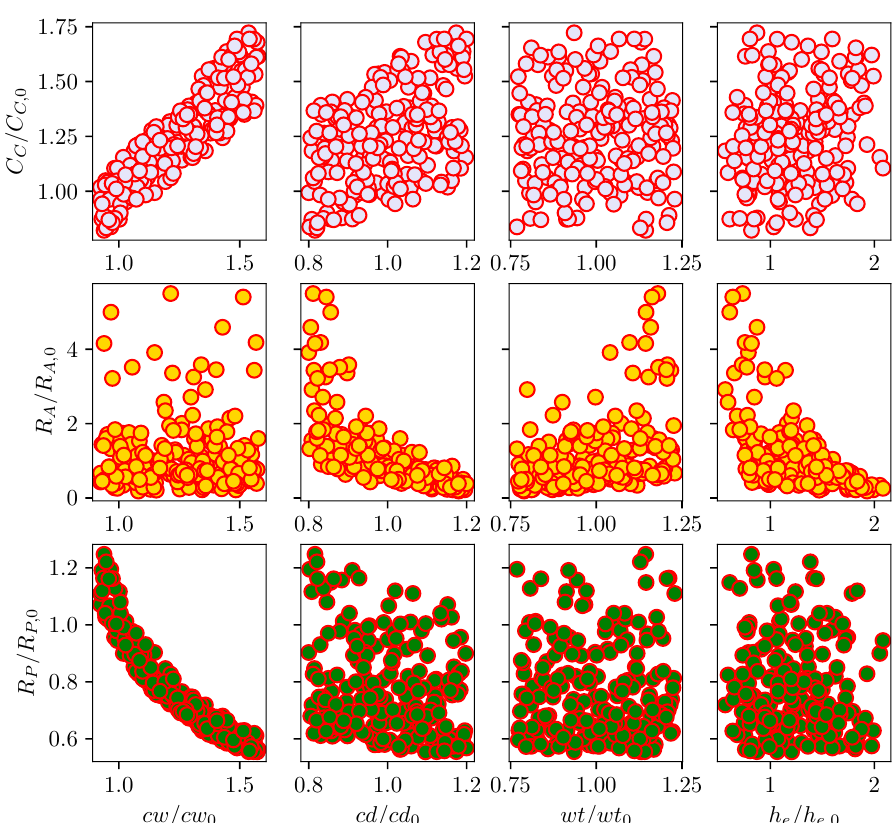
Figure 18. Scatter plot of circuit element coefficients (resistance and capacitance) with geometrical parameters of channel width, depth, wall thickness and electrode height. The parameters are normalized with the base channel of the existing RC1536 inkjet